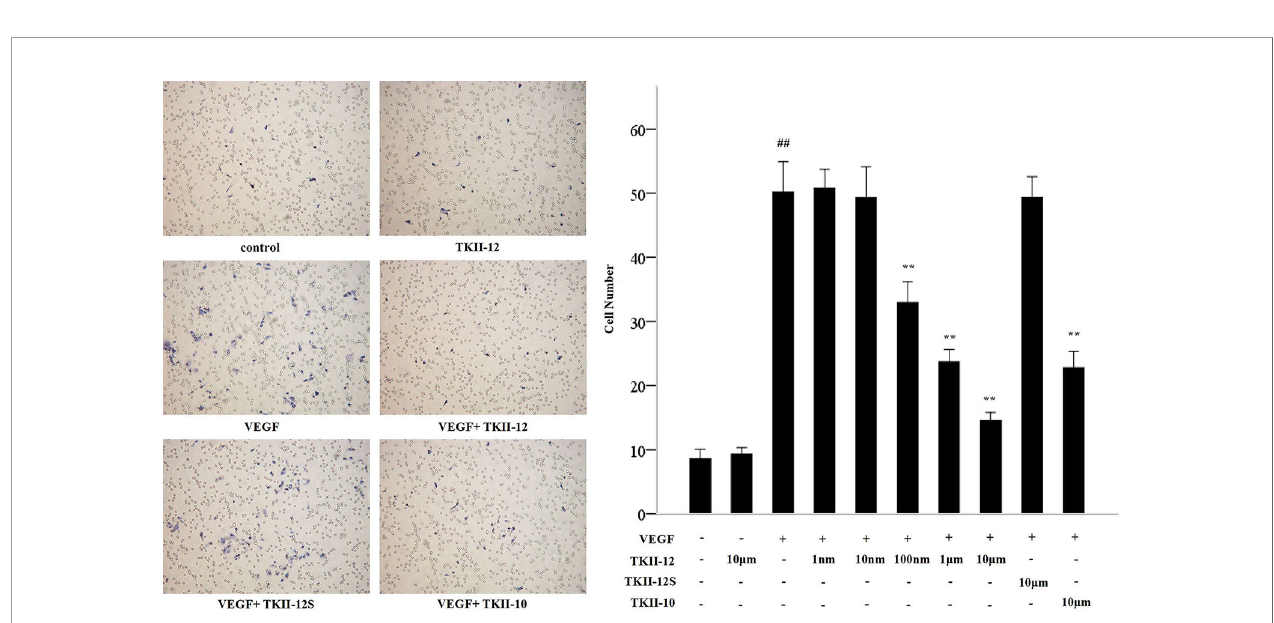
FIGURE 3 | Effects of TKII-12 on vascular endothelial growth factor (VEGF)-induced HRMECs migration in vitro . Inhibitory effect of TKII-12 on endothelial cell migration toward VEGF was assessed by a Transwell chamber 24 h after treatment. ** p < 0.01 versus the VEGF group. ## p < 0.01 versus the control group.